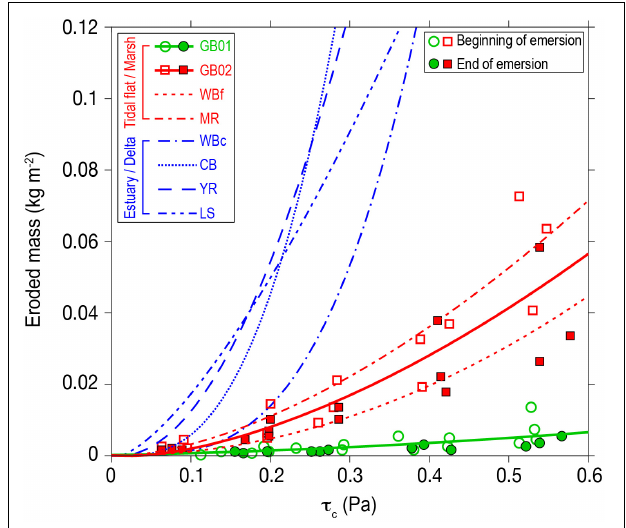
FIGURE 5 | Relationship between eroded mass and erosion threshold ( τ c ) in GB01 (green circles) and GB02 (red squares). Data at other sites are from Sanford (2006); Dickhudt et al. (2009), Wiberg et al. (2013), and Xu et al. (2014, 2016). See Table 2 for site information in